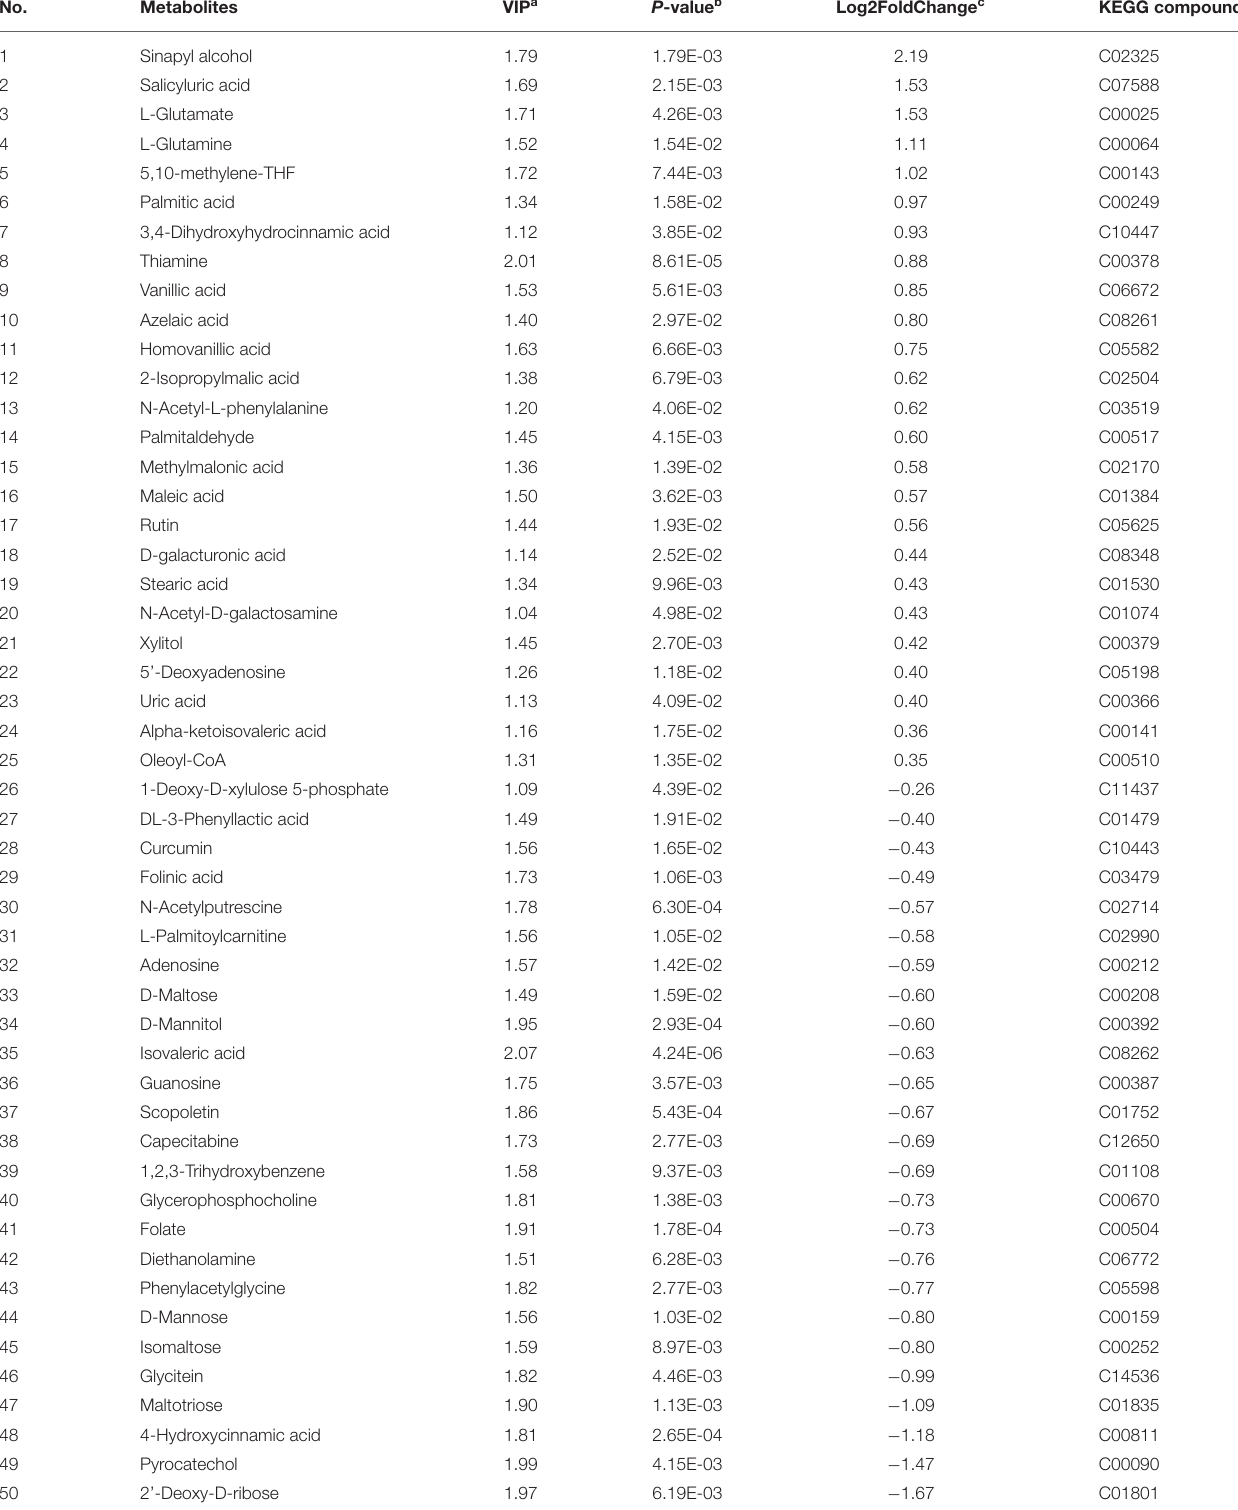
TABLE 3 | DAMs between C Las-infected and healthy